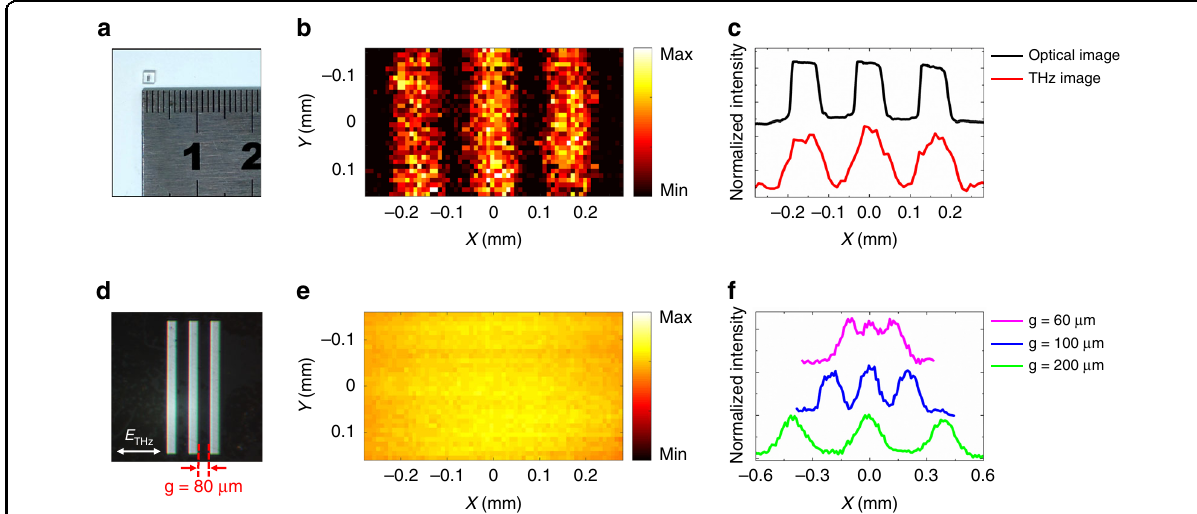
Fig. 2 Imaging capability. a Metallic resolution test chart and a ruler. The chart had three chromium (Cr) stripes on a glass substrate that were separated by two 80 µm slit widths. b Near- fi eld image of the chart acquired at 1.35 THz. c Normalized THz and optical intensity pro fi le curves extracted from b and d along the X direction. d Magni fi ed view of the chart, obtained with an optical microscope. The orientation of the THz polarization is also given. e Far- fi eld image of the chart acquired at 1.35 THz. f Normalized intensity pro fi les extracted from near- fi eld images acquired at 1.35 THz of three other test charts having slit widths of 60, 100, and 200